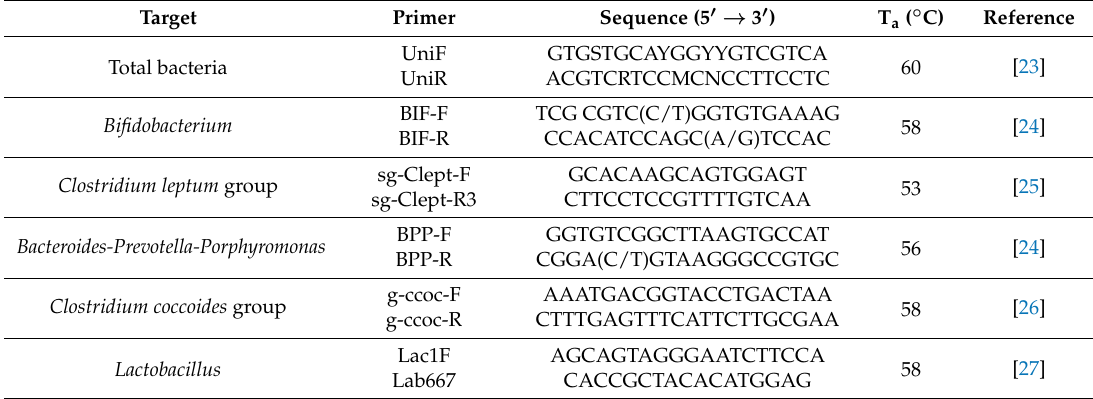
Table 1. The primers used in the real-time polymerase chain reaction (RT-PCR)